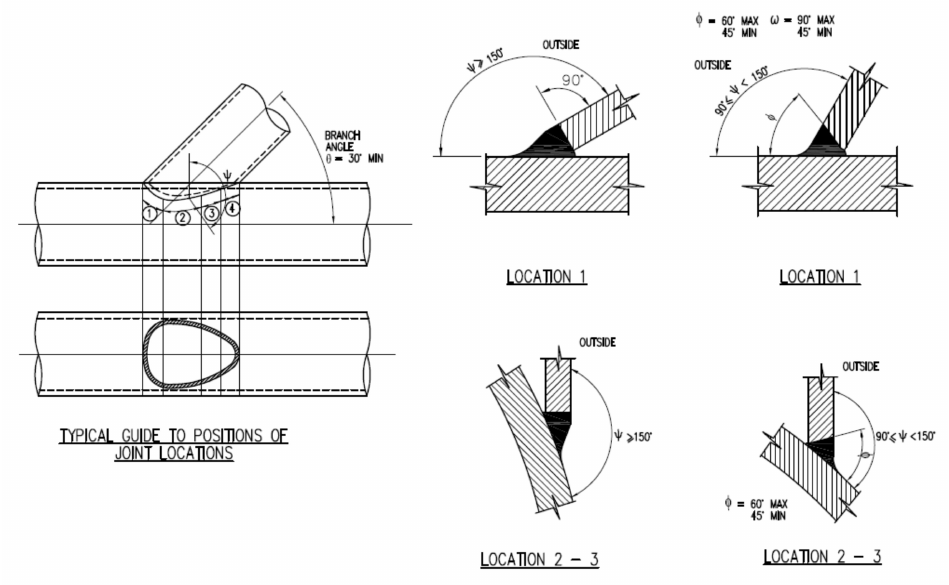
Figure 11. Weld profile specifications as issued to the fabricator for these tests in line with appropriate standards, see Section 4.4. Specimen DT1 was cut into segments post-testing each 20 ◦ from the saddle to the crown to measure the weld profile’s cross-section at the brace-to-chord intersection accu- rately. The shape of the weld profile modelled was based on the measured cut segments shown in Figure 12. At the saddle, the brace was cut back to normal to the axis of the brace cylinder. At the crown, the parent material was assumed to be cut back to approximately 45 ◦ and then filled so that the intersection between the weld and the brace was at a right angle. The weld profile was a smooth transition based on an elliptical profile between the cut segments.